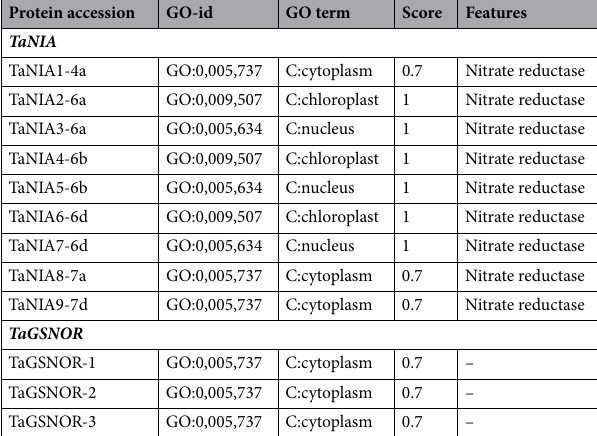
Table 3. Subcellular location of all the identified TaNIA and TaGSNOR